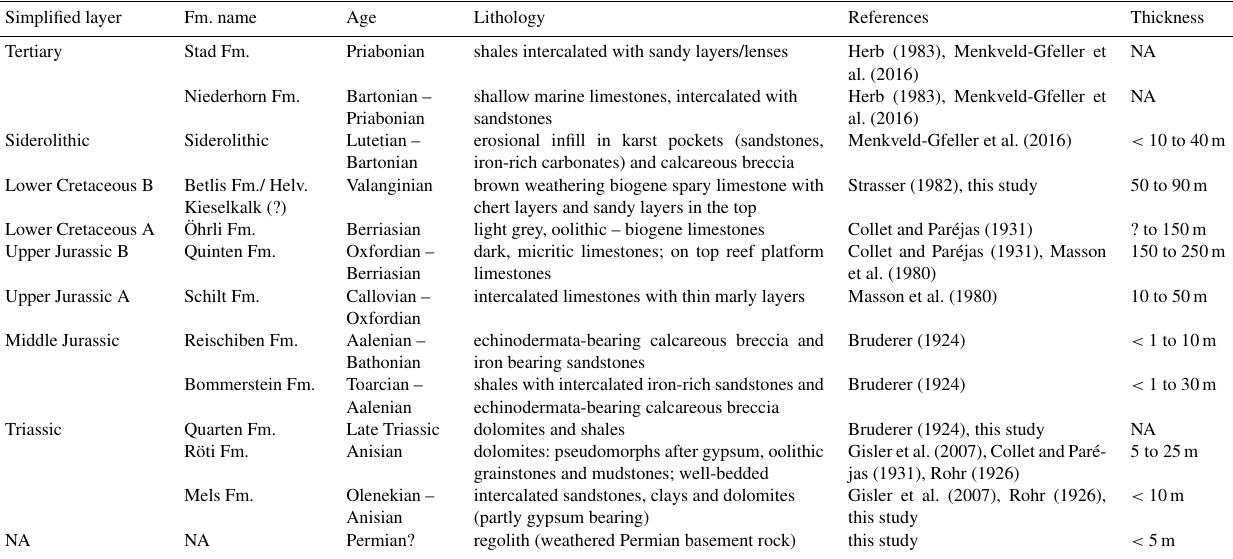
Table 2. Key stratigraphic horizons with most important features and references (for a detailed discussion, see Appendix A). NA – not available.